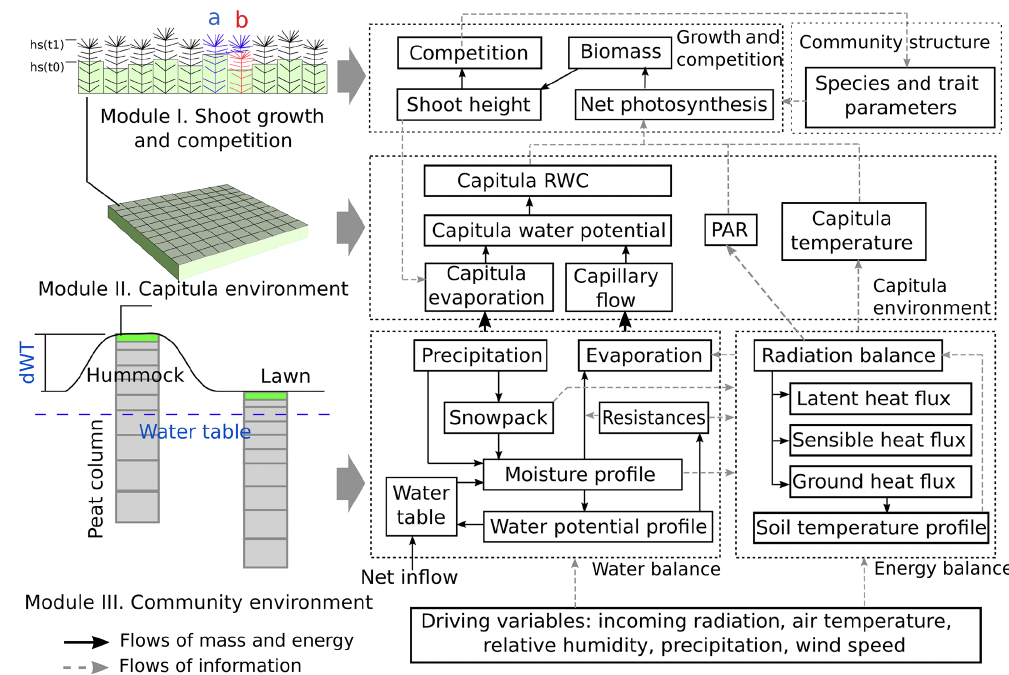
Figure 1. Framework of the Peatland Moss Simulator (PMS). Table 1. Species-specific values of morphological and photosynthetic parameters for S. magellanicum and S. fallax . The parameters include the capitulum density ( D S ), the capitulum biomass ( B cap ), the specific height of the stem ( H spc ), the maximal gross photosynthesis rate at 20 ◦ C ( P m20 ), the respiration rate at 20 ◦ C ( R s20 ), the half-saturation point of photosynthesis ( α PPFD ), and the polynomial coefficients ( a W0 , a W1 , and a W2 ) for the responses of net photosynthesis to capitulum water content. Parameter values are given as the mean ± standard deviation.